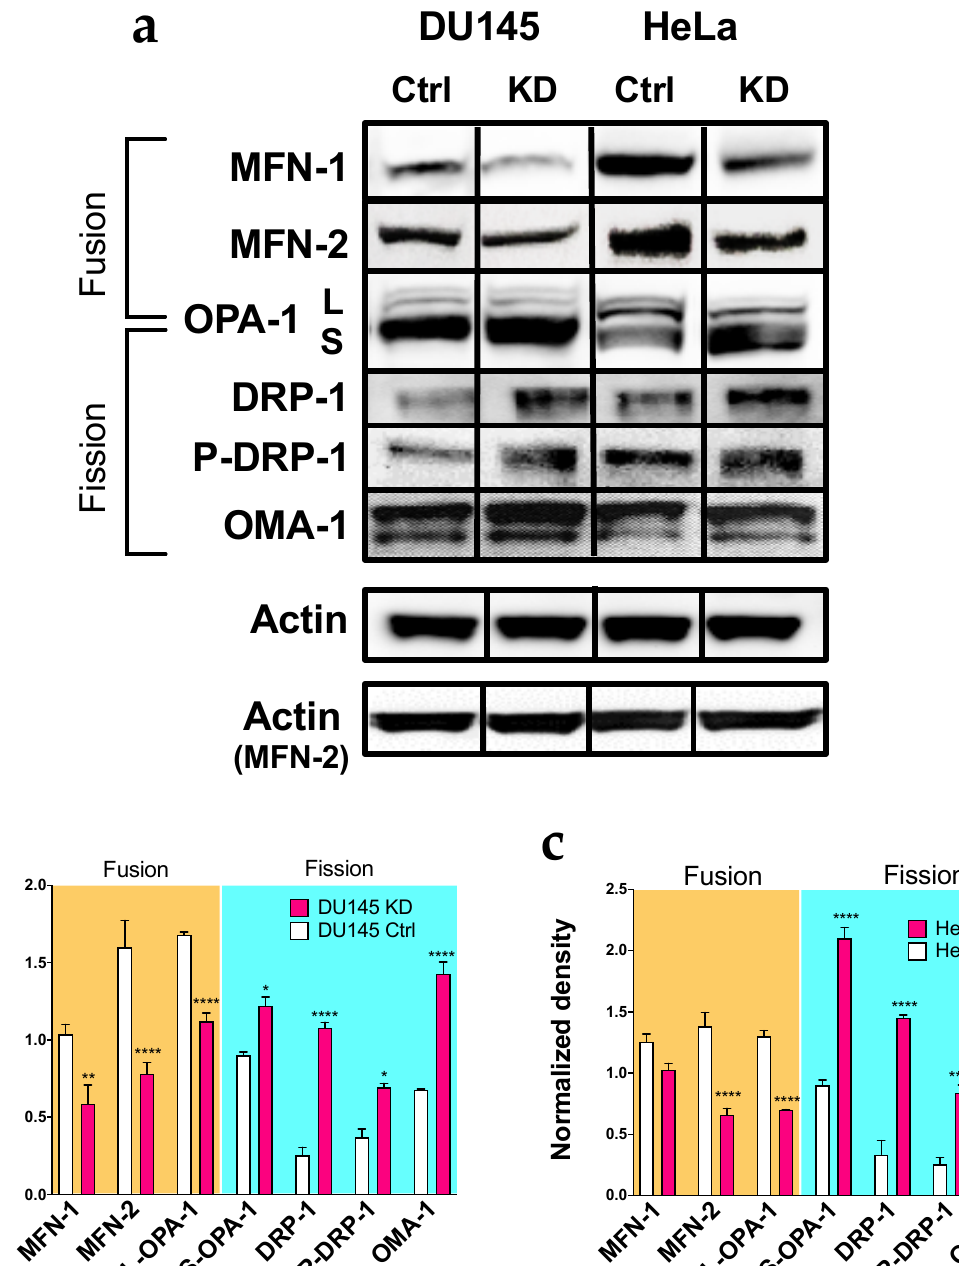
Figure 1. Silencing for Kv10.1 results in an overexpression of proteins involved in fussion processes. ( a ) representative images of Western Blot of proteins involved in mitochondrial dynamics in DU145, DU145KD, HeLa and HeLa KD cells. Actin was used as a loading control in all cells. The bands correspond to t = 72 h of the same blot for each cell line, except for MFN-2, which is a different membrane, and therefore has a different actin loading control. ( b , c ) Densitometric analysis of the protein content in DU145, Du145KD ( b ), HeLa and HeLa KD cells ( c ); the values were normalized to the loading control. Bars represent the mean of the three independent experiments. Error bars indicates SEM (* p < 0.05, ** p < 0.001, **** p < 0.0001, 2-waz ANOVA ).